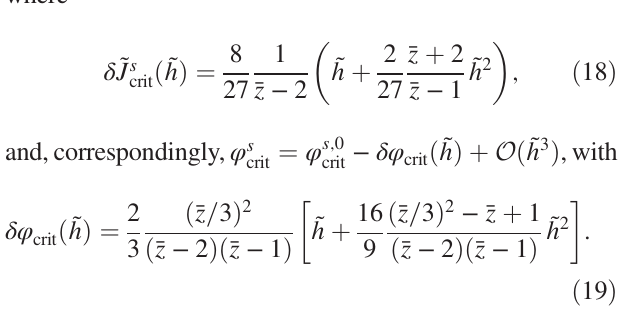
FIG. 5. Statical critical point as a function of the force Symbols depict the exact solution using a converged Newton ’ s series, and the gradient line depicts the two-term (so-called quadratic) approximation of the complete Newton ’ s series, which is very accurate for any pulling and up to a moderate pushing ˜ h ≥ − 1 . Explicit expressions are given in Appendix E. force, i.e., The black line corresponds to the prediction of second-order perturbation theory from Eqs. (18) and (19), which is valid for small